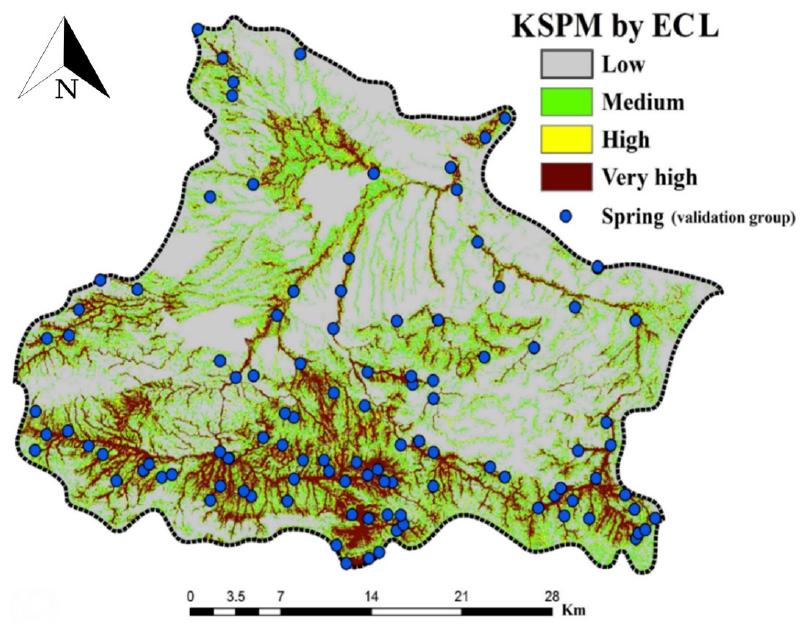
Figure 7. Karst spring potential map produced by the generated map of ensemble CF and LR (ECL) modelling. (ECL)